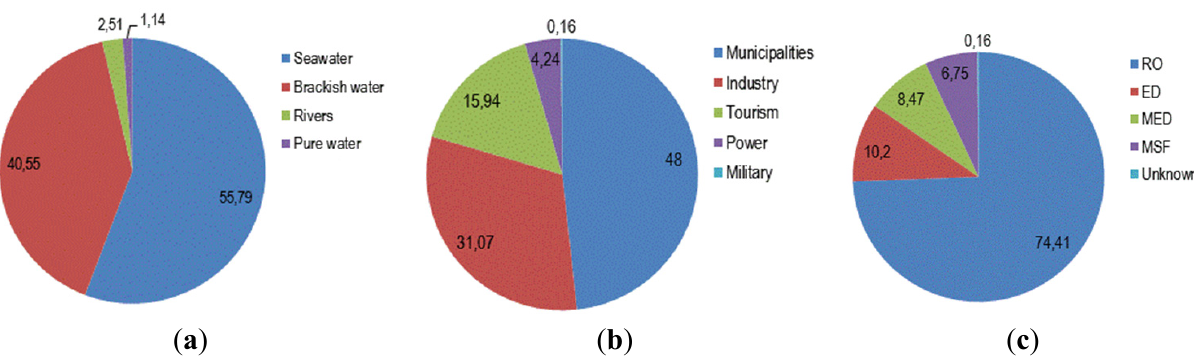
Figure 6. Desalinated water production according to: ( a ) feed water; ( b ) its uses; and ( c ) the used technology, in Greece. Adapted from